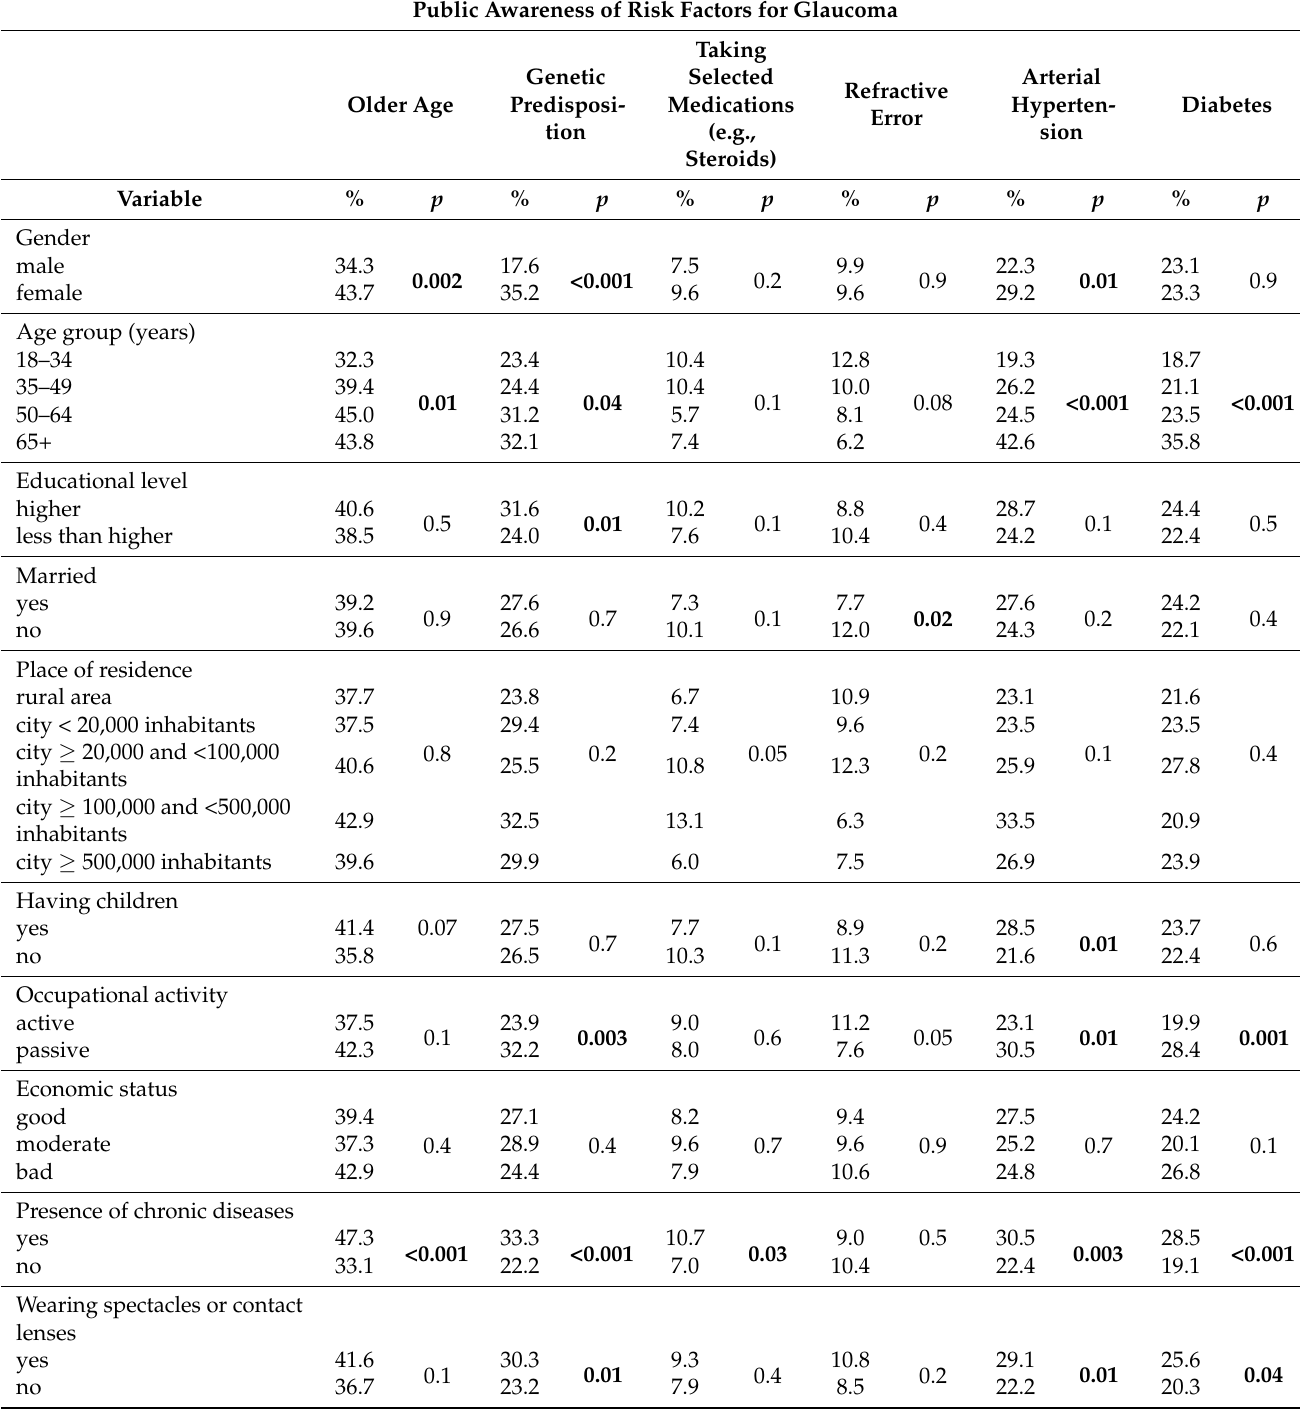
Table 4. Public awareness of risk factors for glaucoma by sociodemographic factors (n = 1076). Public Awareness of Risk Factors for Glaucoma Taking Arterial Selected Genetic Refractive Hyperten- Medications Older Age Predisposi- Error sion (e.g., tion Steroids)